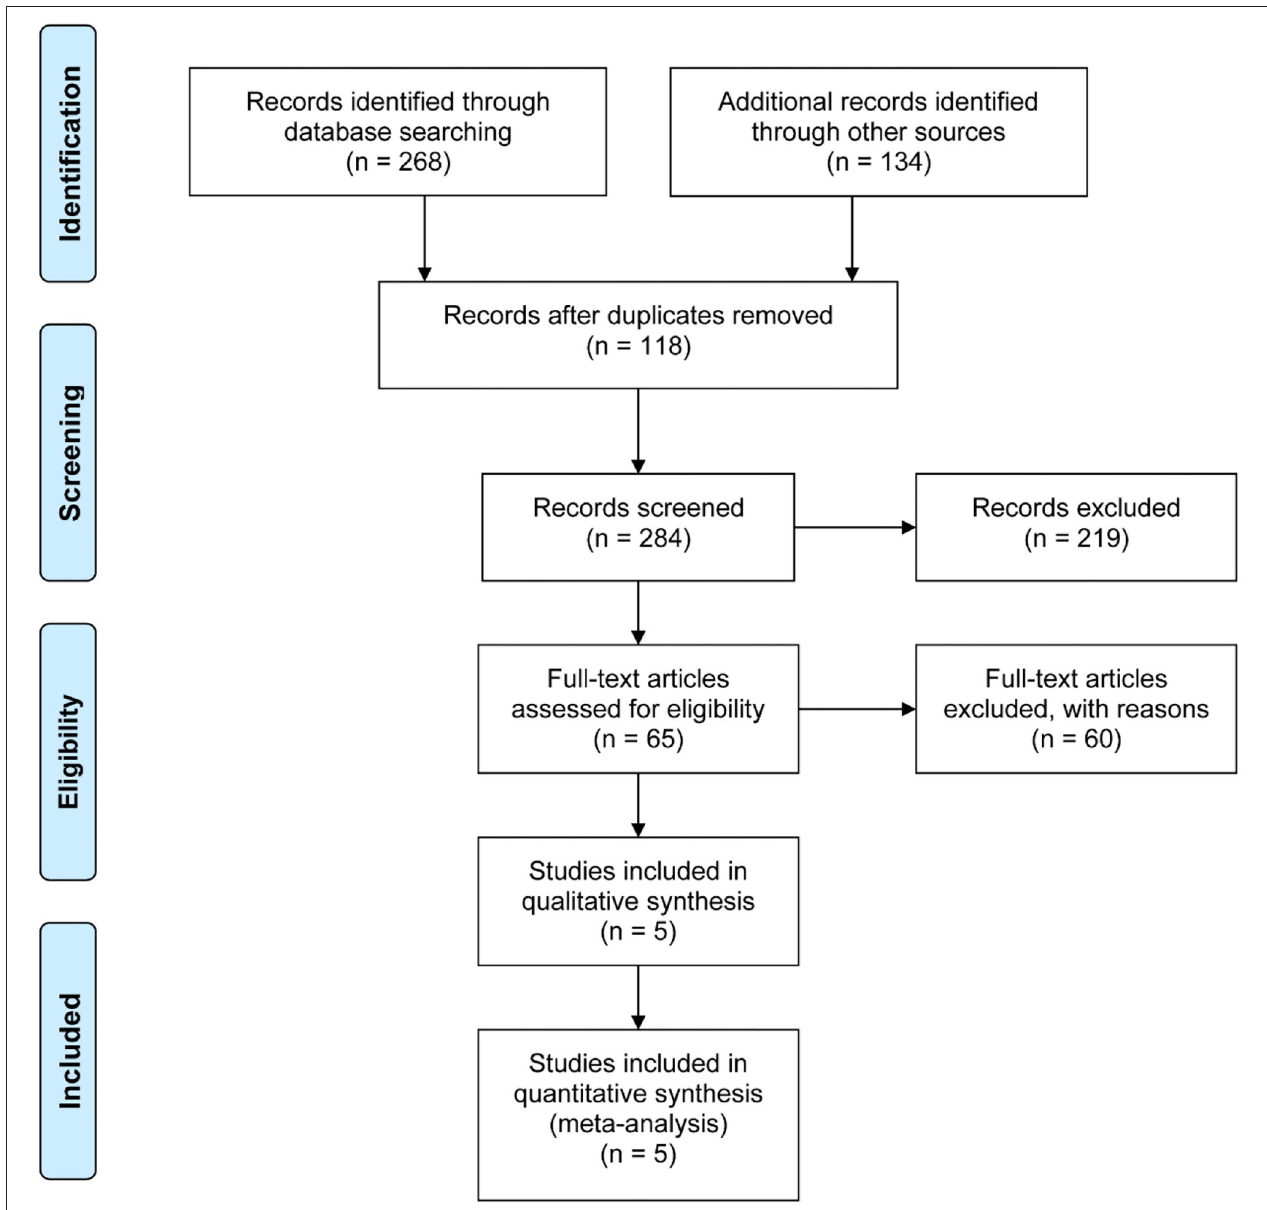
FIGURE 1 | Preferred reporting items for systematic reviews and meta-analysis